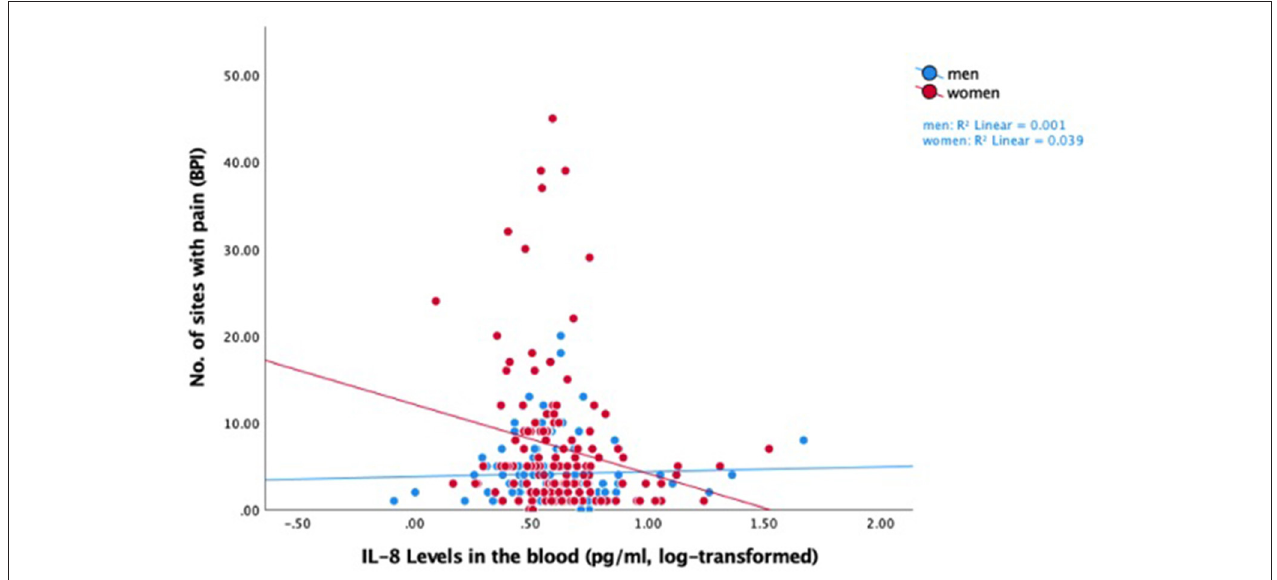
FIGURE 1 | Raw data scatter plot of the relationship between log-transformed IL-8 levels and widespreadness of pain, for men and women in the pelvic pain